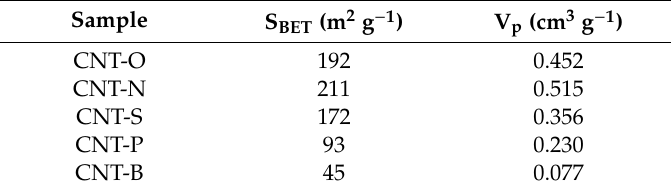
Figure 2. Pore size distributions obtained by Non-Linear Density Function Theory (NLDFT). Table 2. Textural characterization of carbon nanotubes.